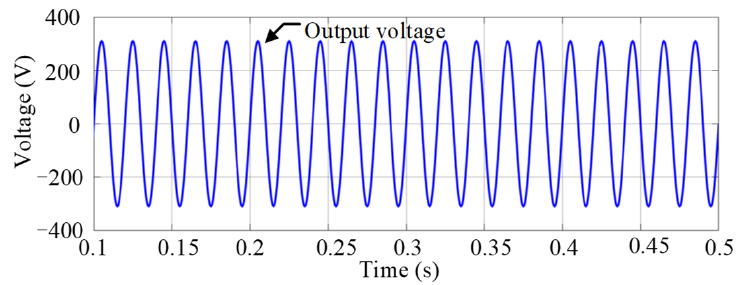
Figure 27. Pre-stage reverse output voltage waveform.